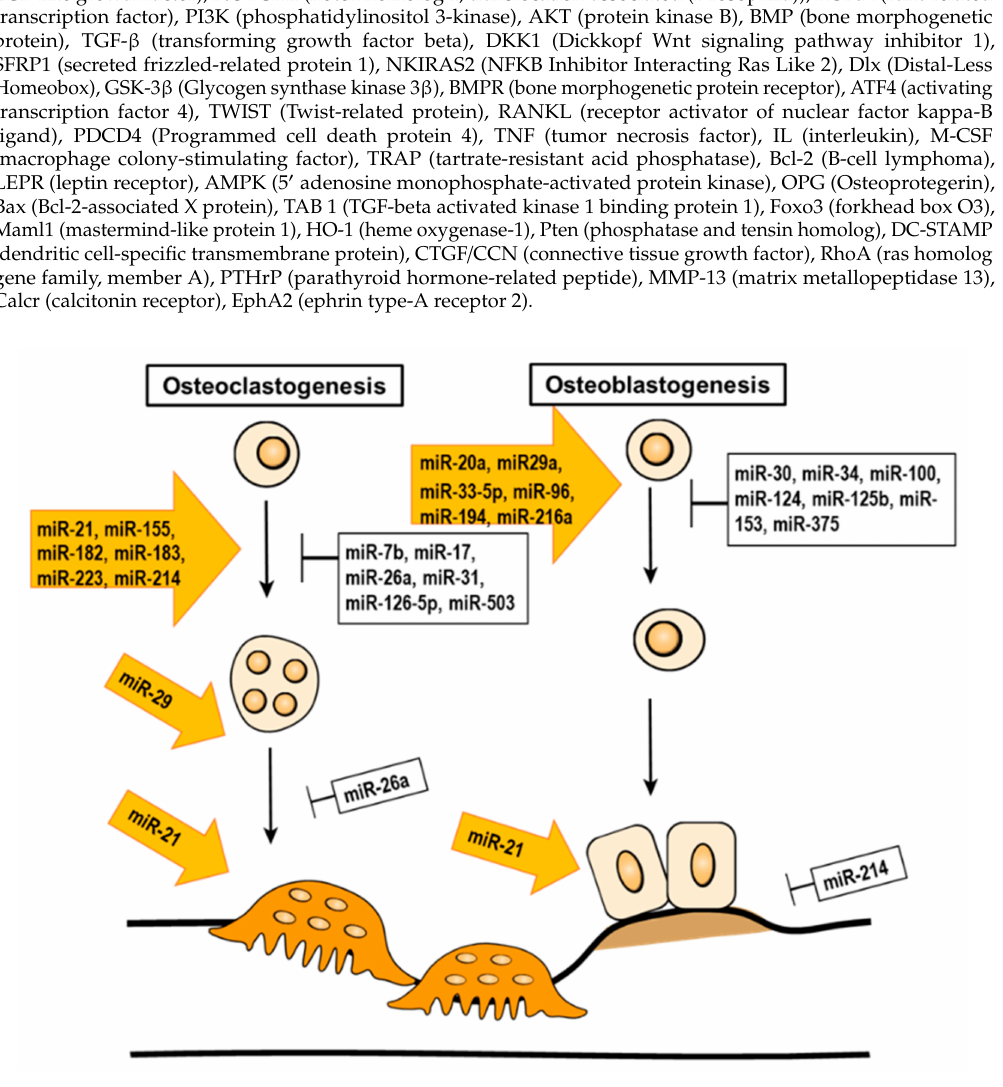
Figure 4. The epigenetic regulation of miRNA in bone